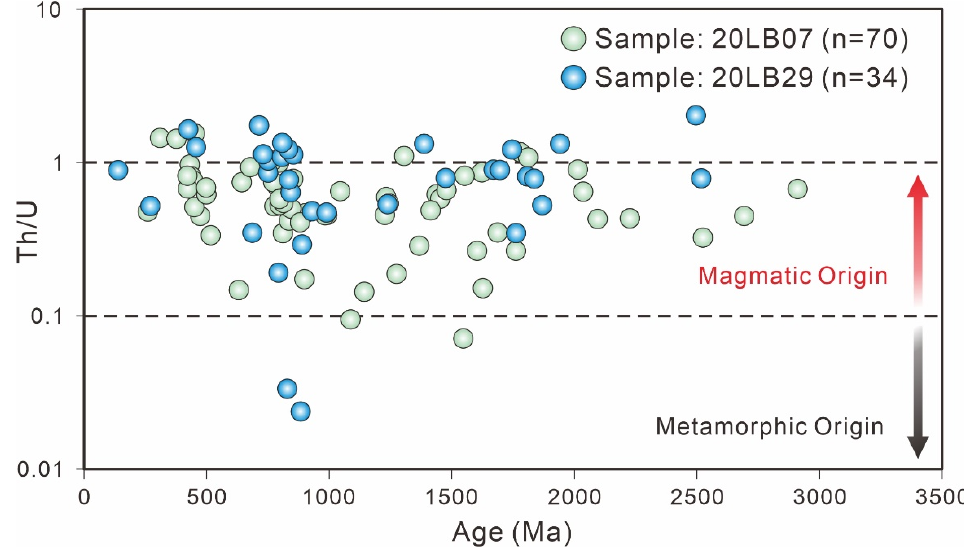
Figure 8. Th/U ratios of the detrital zircon from the Middle Devonian Liba Group.